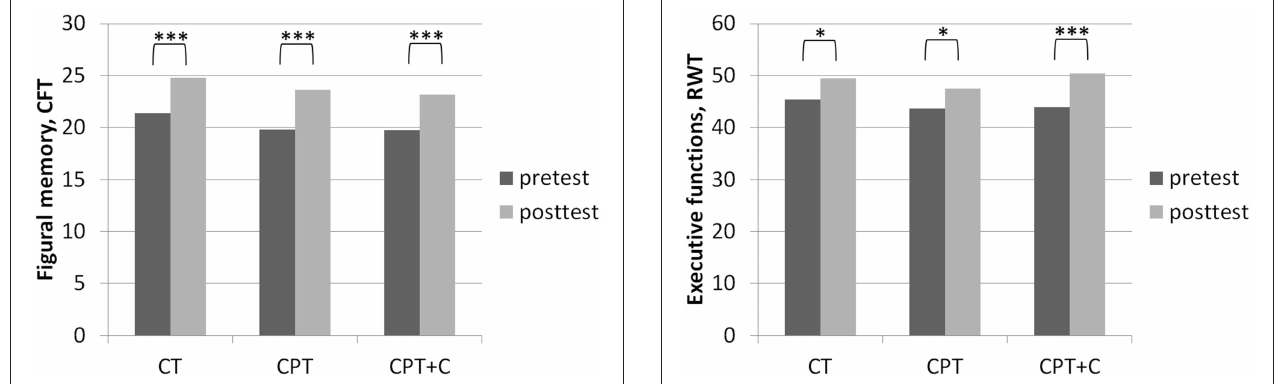
p = 0.04, ω = 0.58, and IGF-1, F (1 , 46) = 3.99, MSE = Predictors of Cognitive Improvement within CPT = 0.08, from pre- to post-test. Post- 327.54, p = 0.05, η 2 p To analyze predictors of cognitive improvement within CPT we used backwards multiple regressions to ensure achievement of best model fit while taking into account each relevant predictor. Assuming a maximum of five predictors per model (based